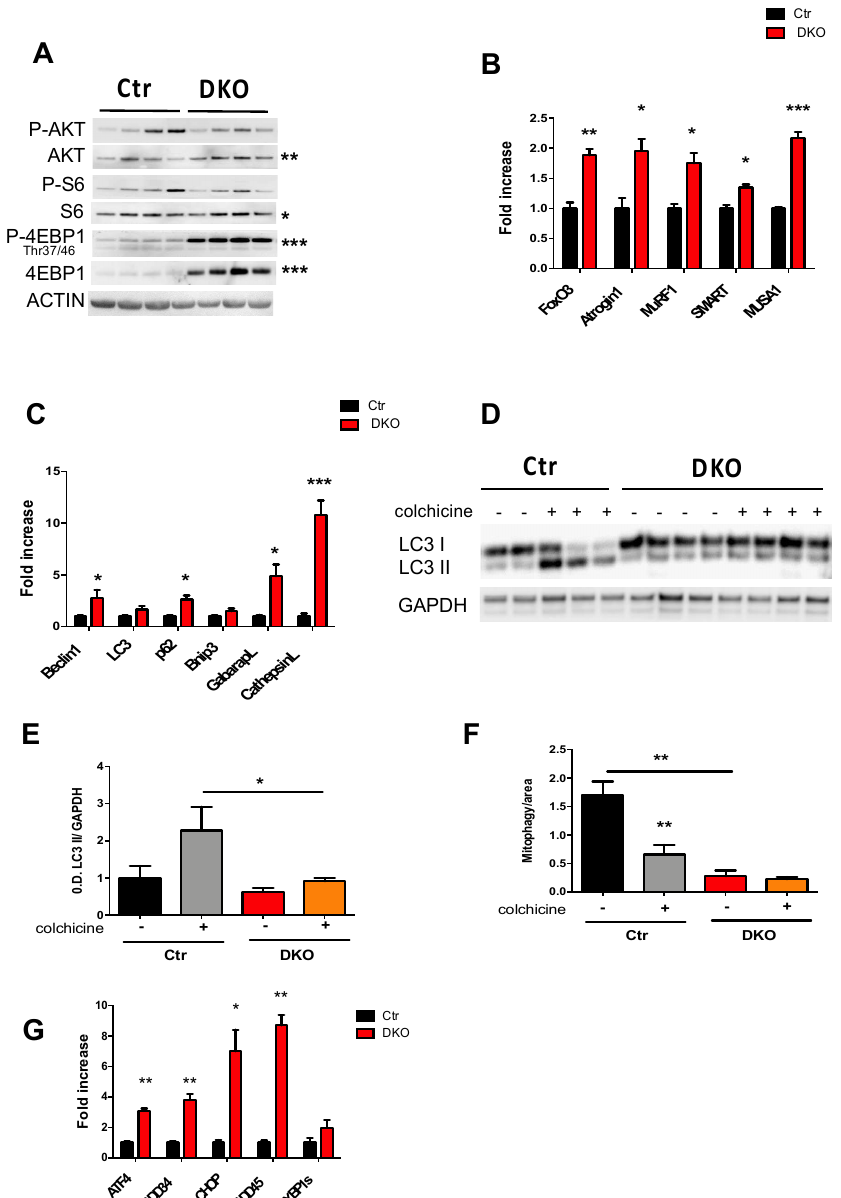
Figure 3. Protein degradation pathways were activated with acute inhibition of Opa1 and Drp1 in adult muscles. ( A ) Total protein extracts from GNM muscles were immunoblotted with the indicated antibodies. Statistical significance of densitometric analysis is indicated on the right. Data are normalized to actin. ( B ) RT-PCR analysis of FoxO-dependent transcripts showing increase in GNM DKO muscles of FoxO3, and the E3 ubiquitin ligases, Atrogin1, MuRF1, SMART and MUSA1. ( C ) Quantitative PCR analysis of autophagy-related transcripts showed a significant induction of autophagy markers in GNM DKO muscles. Immunoblot ( D ) and relative densitometric quantification ( E ) of GNM muscle lysates from colchicine treated mice showed a block in autophagy flux after Opa1 and Drp1 inhibition. ( F ) Mitophagy flux was analyzed by electroporation of a reporter plasmid (mitochondria-targeted mKeima (mt-mKeima)) into flexor digitorum brevis muscles of adult control and DKO mice, and changes of fluorescent spectra were detected and normalized to the fiber area. ( G ) RT-PCR analysis showing the activation of PERK-dependent Unfolded Protein Response in GNM muscles. Data are shown as mean ± SEM. Two-tailed unpaired Student’s t -test and 2-way ANOVA were used. Statistical significance: * p < 0.05, ** p < 0.01, *** p < 0.001, compared to